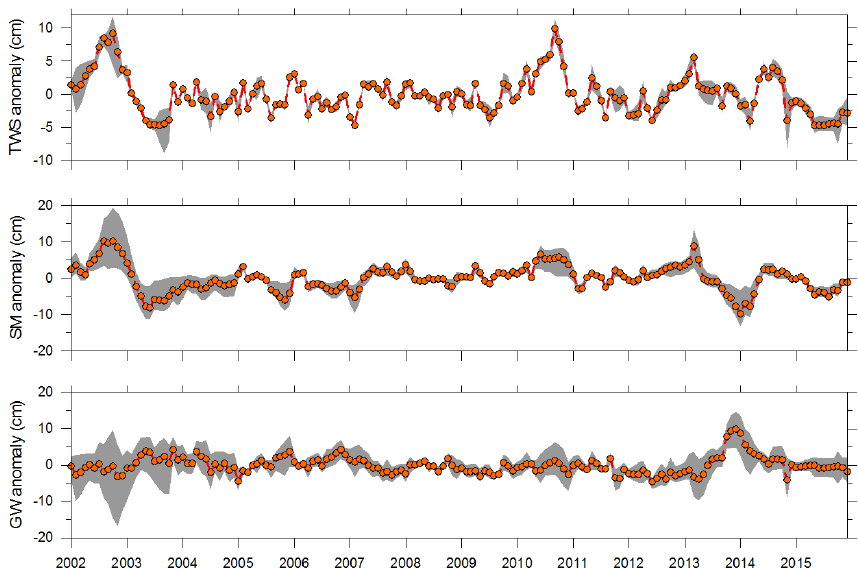
Figure 10. Ensemble mean and range (minimum–maximum; shaded) of GRACE-TWS (from JPL, CSR, GFZ), simulated soil moisture (SM; from GLDAS models VIC, CLM, Noah, and MOSAIC), and resulting groundwater (GW; from 12 combinations, i.e. three TWS products and four models) area-averaged anomalies for Germany for the period